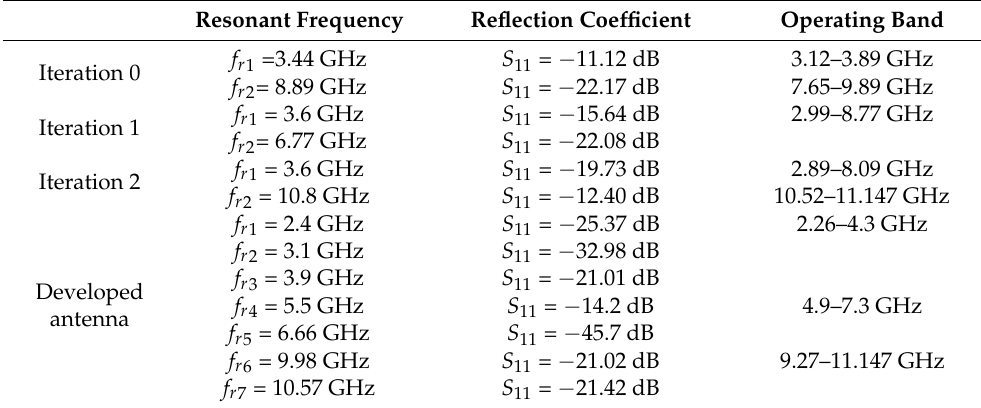
Table 2. Comparison of results for the various stages of the developed antenna’s design